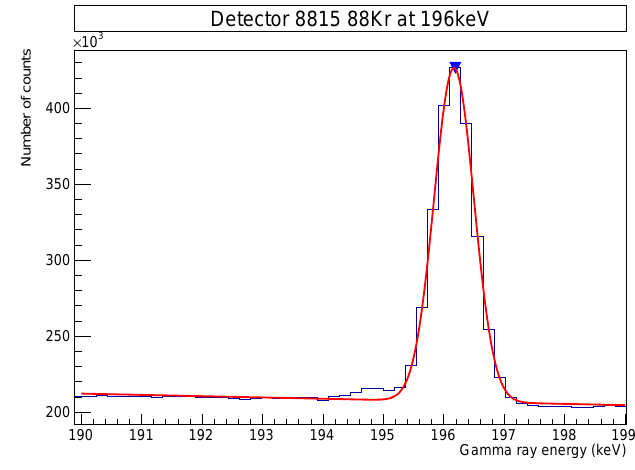
Figure 2. 88 Kr master sum plot fit for the 196 keV γ